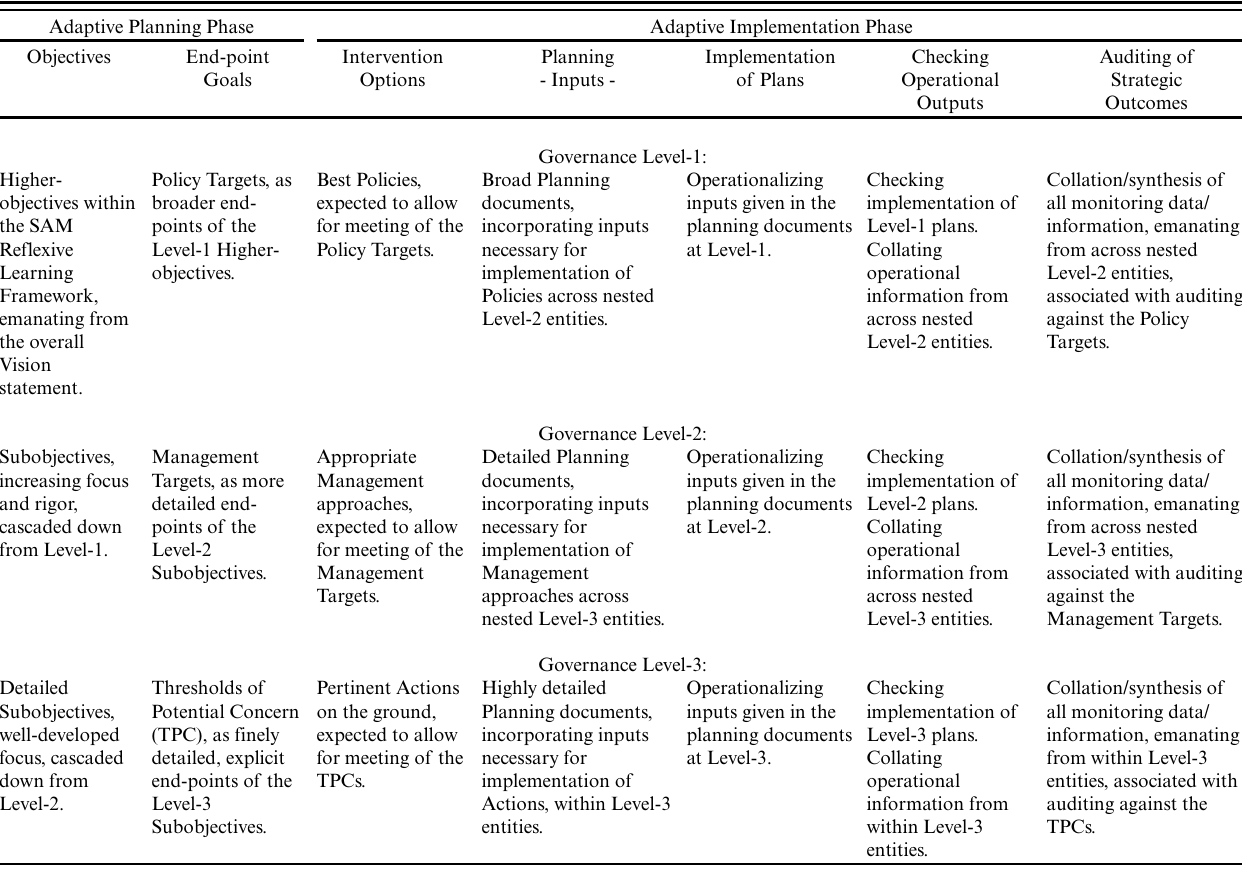
Table 1 . Processes associated with components of the Adaptive Planning and Adaptive Implementation phases of the strategic adaptive management (SAM) cycle used in the SAM Reflexive Learning Framework (SRLF), applicable to SRLF Level-1, Level-2, and